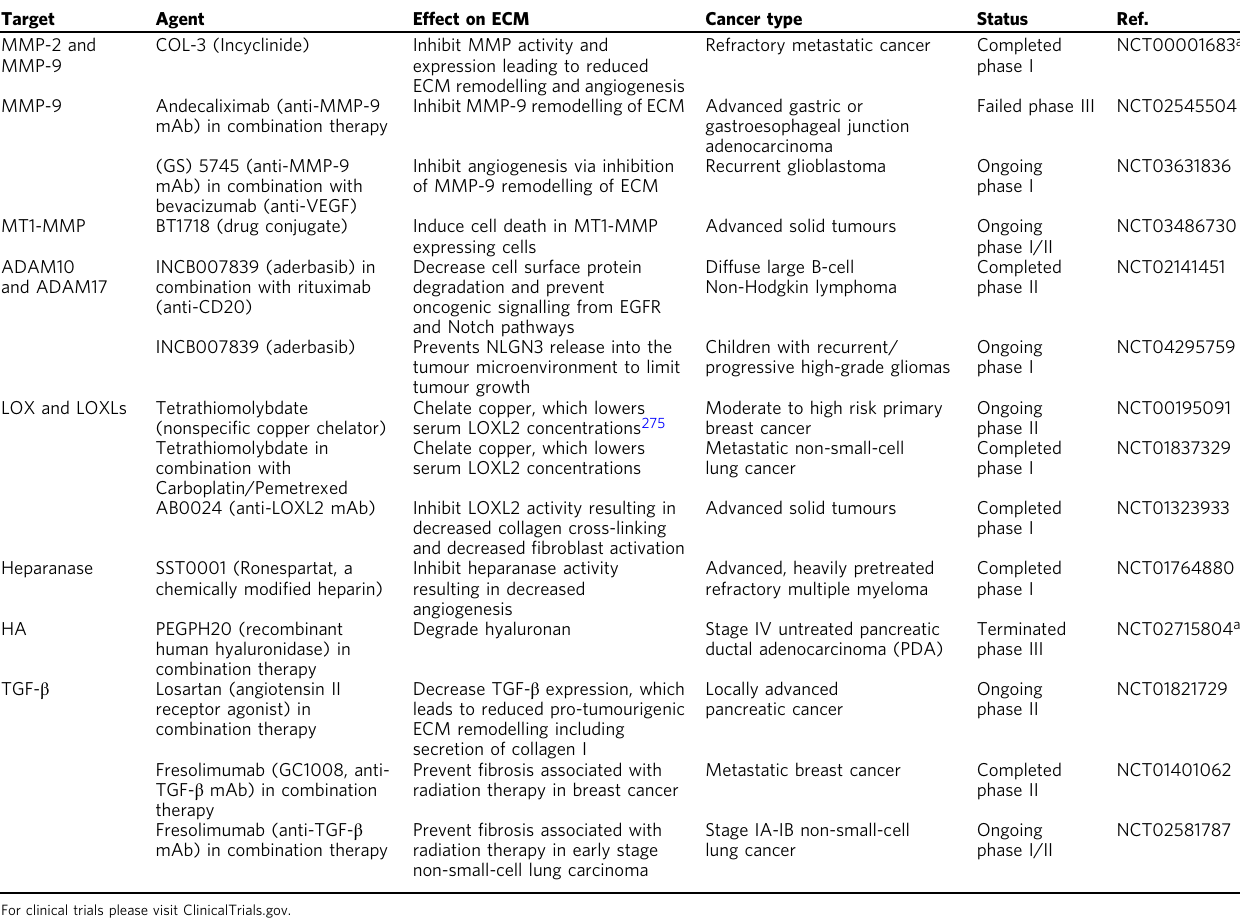
Table 2 Clinical trials of cancer therapies targeting ECM and ECM-associated